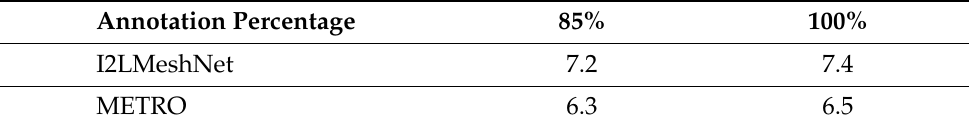
Table 6. PA-MPJPE with the annotation percentage of 85% and 100%.